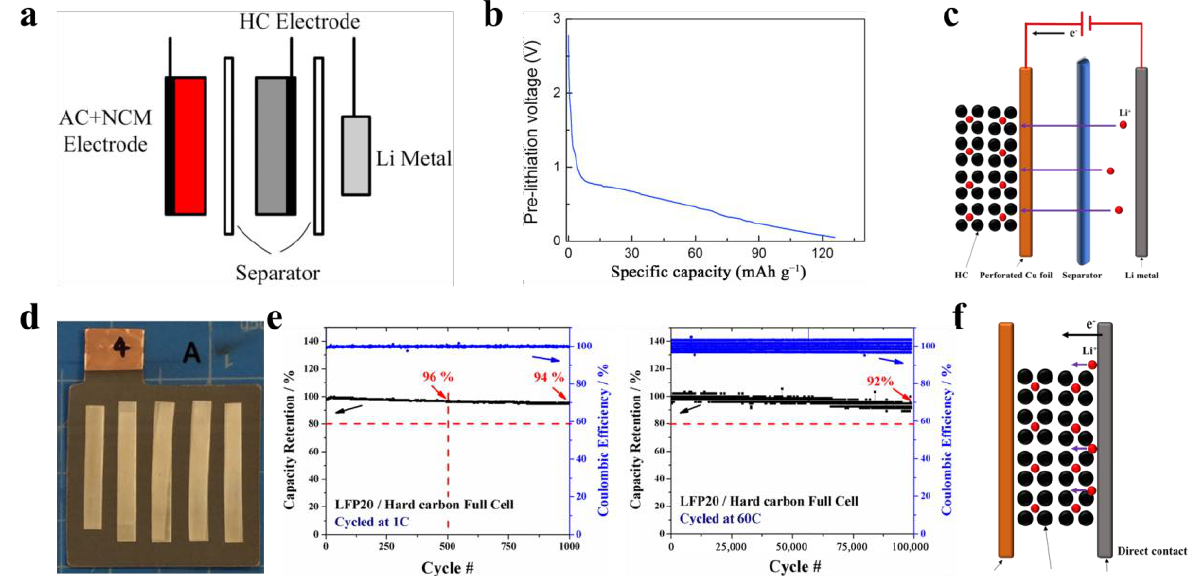
Figure 7. (NCM523+AC)//pre-lithiated HC LIBCs: ( a ) Schematic structure of three-electrode LIBC; ( b ) Voltage profile of pre-lithiation process for HC anode [56]; ( c ) Schematic diagram of the EC method. (LFP+AC)//pre-lithiated HC LIBCs: ( d ) HC anode (A) loaded with Li metal strips; ( e ) Cycle performance [58]; ( f ) Schematic diagram of the IS method.